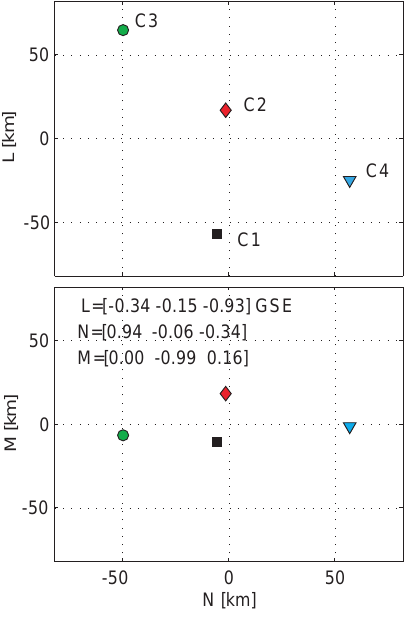
Fig. 5. Location of the Cluster spacecraft corresponding to Fig. 6. L, M and N are the parallel and two perpendicular axes, respec- tively, in a field-aligned coordinate system. L is the field-aligned direction, N is the perpendicular component pointing towards the Sun, and M completes the right-handed system. At this time C1 and C2 are at the smallest perpendicular separation and hence al- most on the same field line.